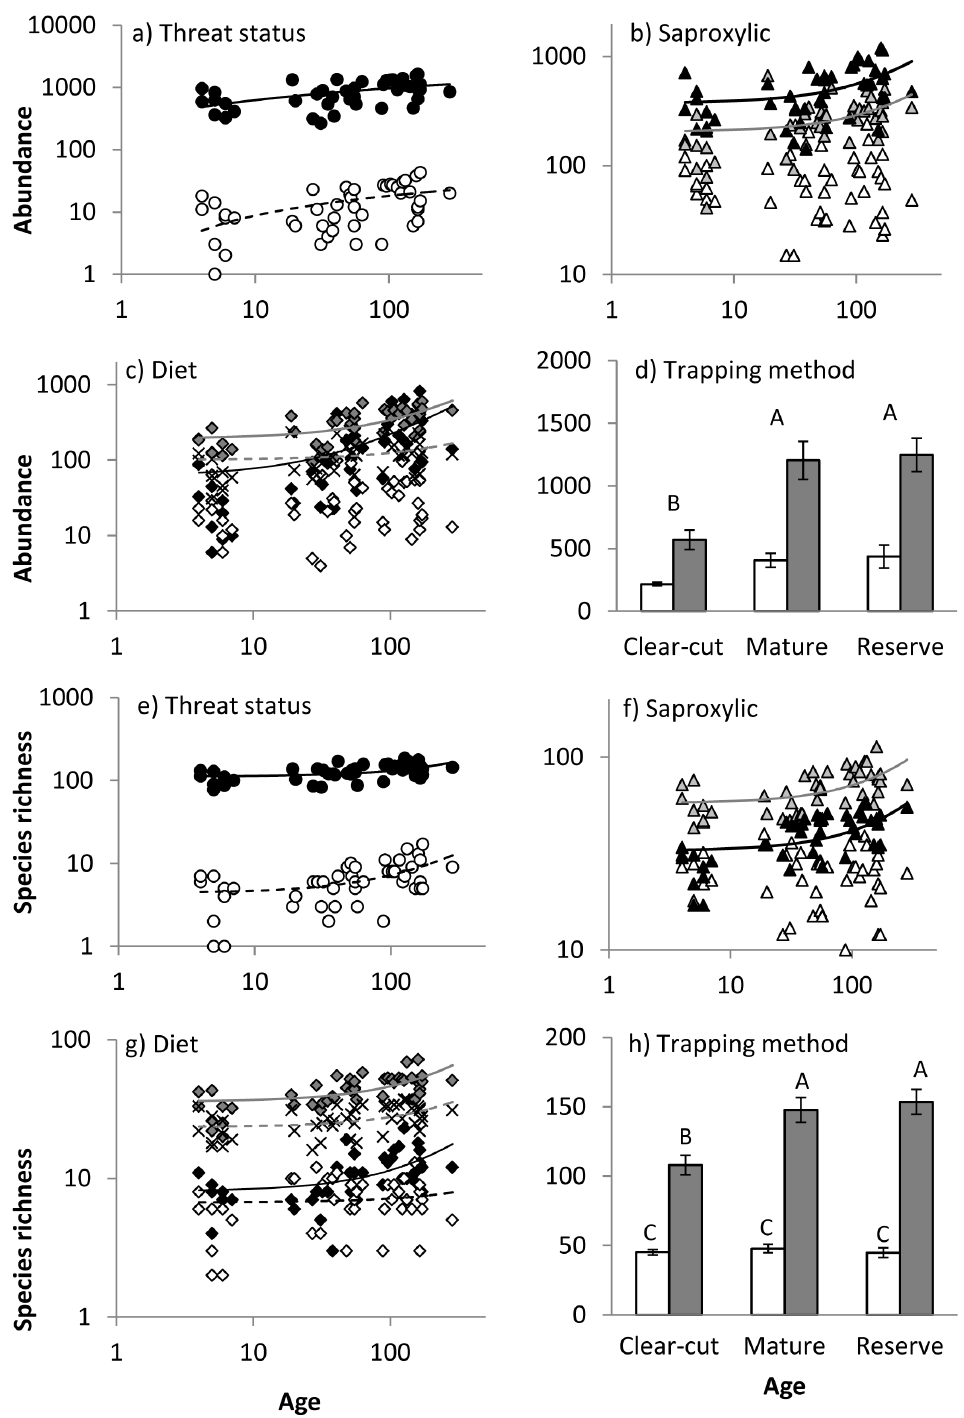
Figure 1. Relationships between stand age and abundance and stand age and species richness for beetle functional groups based on : a) and e) threat status; b) and f) degree to which species are dependent on dead wood; c) and g) diet; and d) and h) trapping method. Symbols are as follows: threat status: common species (●); red-listed species (○); saproxylic : non-saproxylic (Δ); facultative saproxylic (▲); obligatory saproxylic (▲); diet: cambium consumers (♦); detritivores (◊); fungivores (♦); predators (×); trap type: emergence = white bars; flight intercept = grey bars. Only significant or near-significant regression lines are shown. Lines may appear curved due to the log scale of the y-axis. doi: 10.1371/journal.pone.0072764.g001 PLOS ONE |